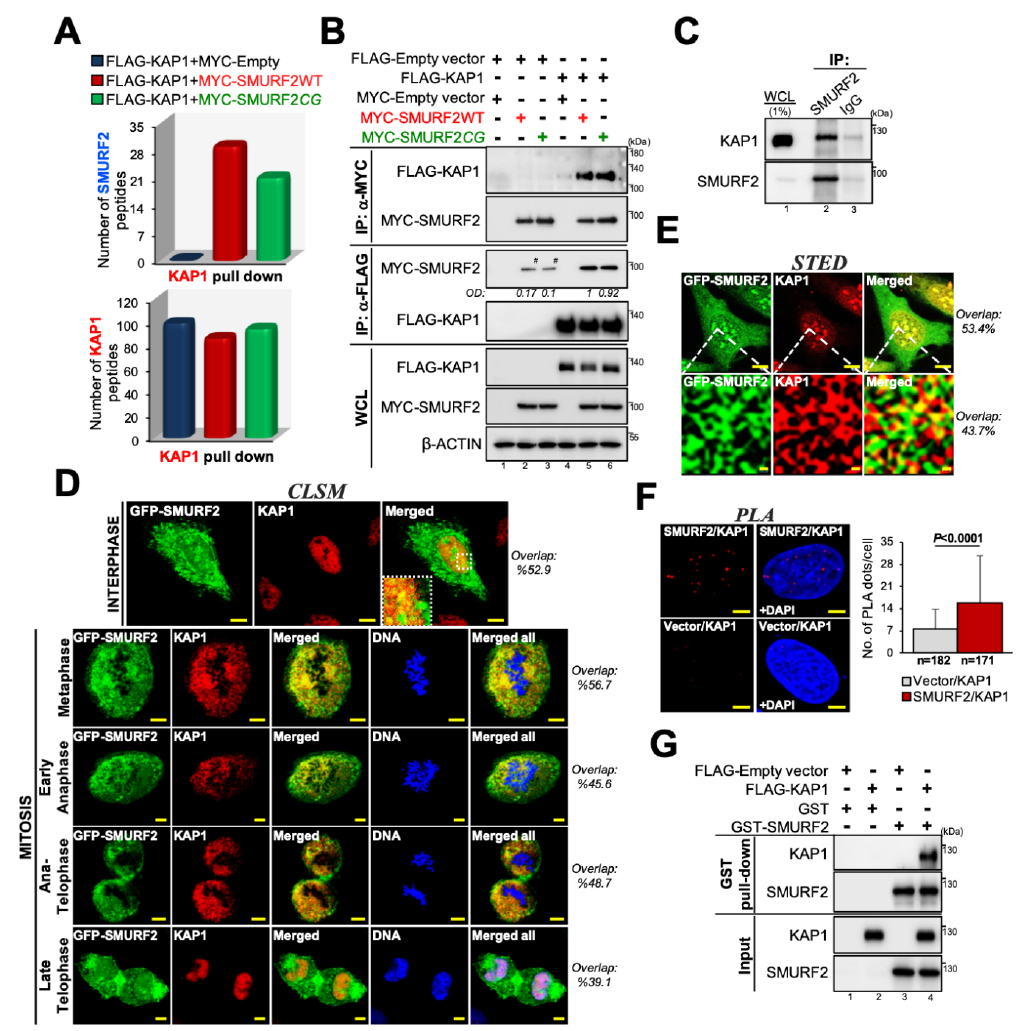
Figure 1. SMURF2 and KAP1 directly interact with each other. ( A ) The number of SMURF2 and KAP1 peptides identified in FLAG-KAP1 immunoprecipitates in HEK-293T cells using MS. SMURF2WT—wild type SMURF2; SMURF2 CG —catalytically-inactive SMURF2 (C716G). ( B ) Reciprocal co-IP analysis showing KAP1 in complex with SMURF2 and vice versa in HEK-293T cells. WCL, whole cell lysates. # -non-specific. ( C ) Endogenous co-IP showing interaction between endogenous SMURF2 and KAP1 proteins in HEK293T cells. Isotype IgG was used as a control. ( D ) Confocal laser scanning microscopy (CLSM) images showing co-localization of GFP-SMURF2 and endogenous KAP1 in interphase and mitotic U2OS cells. DNA was counterstained with Hoechst 33258. Scale bars: 10 µ m and 5 µ m for interphase and mitotic cells, respectively. ( E ) STED microscopy images showing co-localization of KAP1 and GFP-SMURF2 in the U2OS cell nucleus. White rectangles mark the area detailed under the STED microscopy. Scale bars: 10 µ m and 40 nm in the upper and bottom images, respectively. ( F ) PLA showing the sites of direct protein–protein interaction of endogenous KAP1 and MYC-SMURF2 in the U2OS cell nucleus (red signal). Cells transfected with MYC-Empty vector served as a control. Scale bars: 5 µ m. Quantification of the SMURF2-KAP1 PLA data is shown on the right. In total, 171–182 cells were quantified from at least 10 different fields. Data are mean ± SD. ( G ) In vitro GST-pull down assay showing a direct interaction between purified GST-SMURF2 and FLAG-KAP1. The uncropped Western blot images can be found in Figure